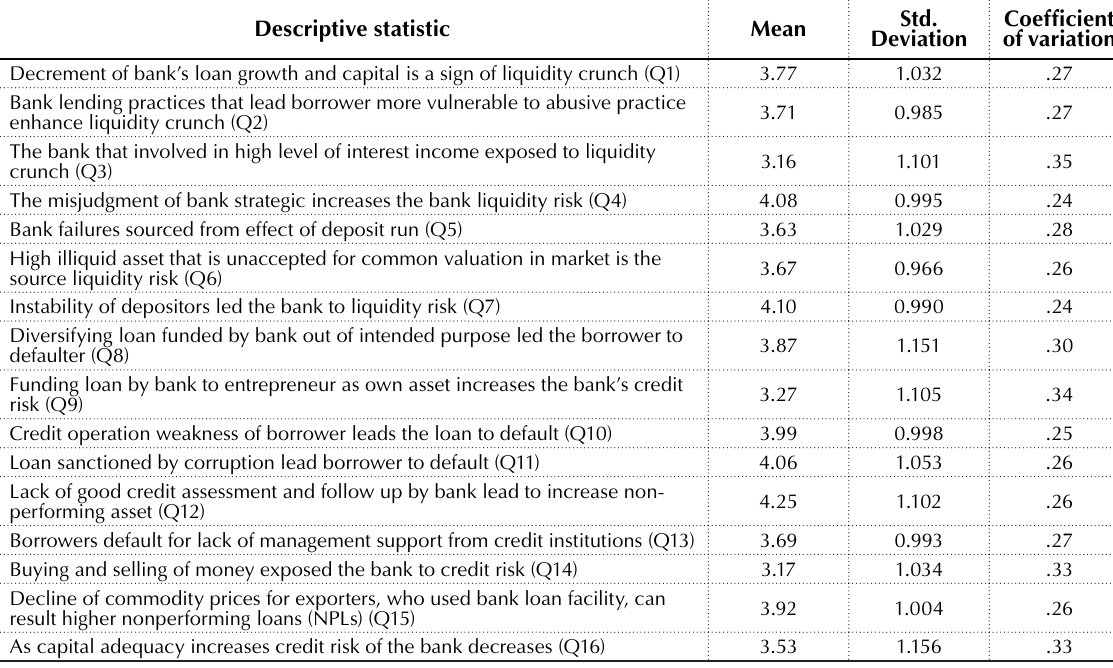
Table 10. Descriptive statistics for credit risk and liquidity crunch